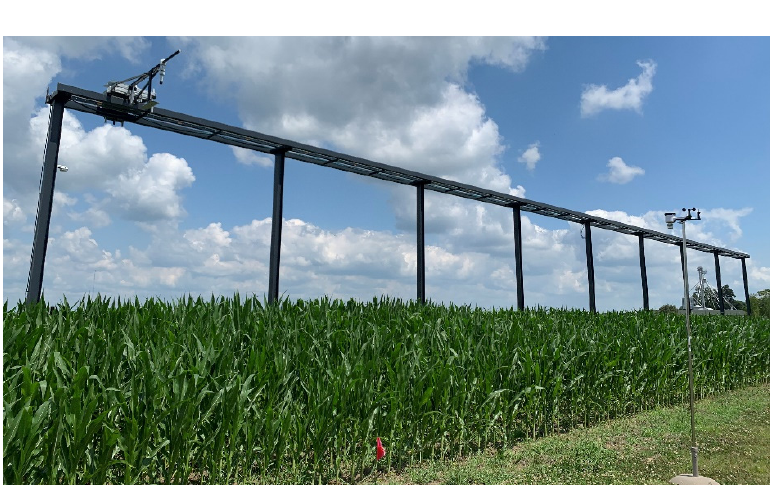
Figure 1. Field VNIR hyperspectral platform at Purdue University. It consists of a VNIR hyper-